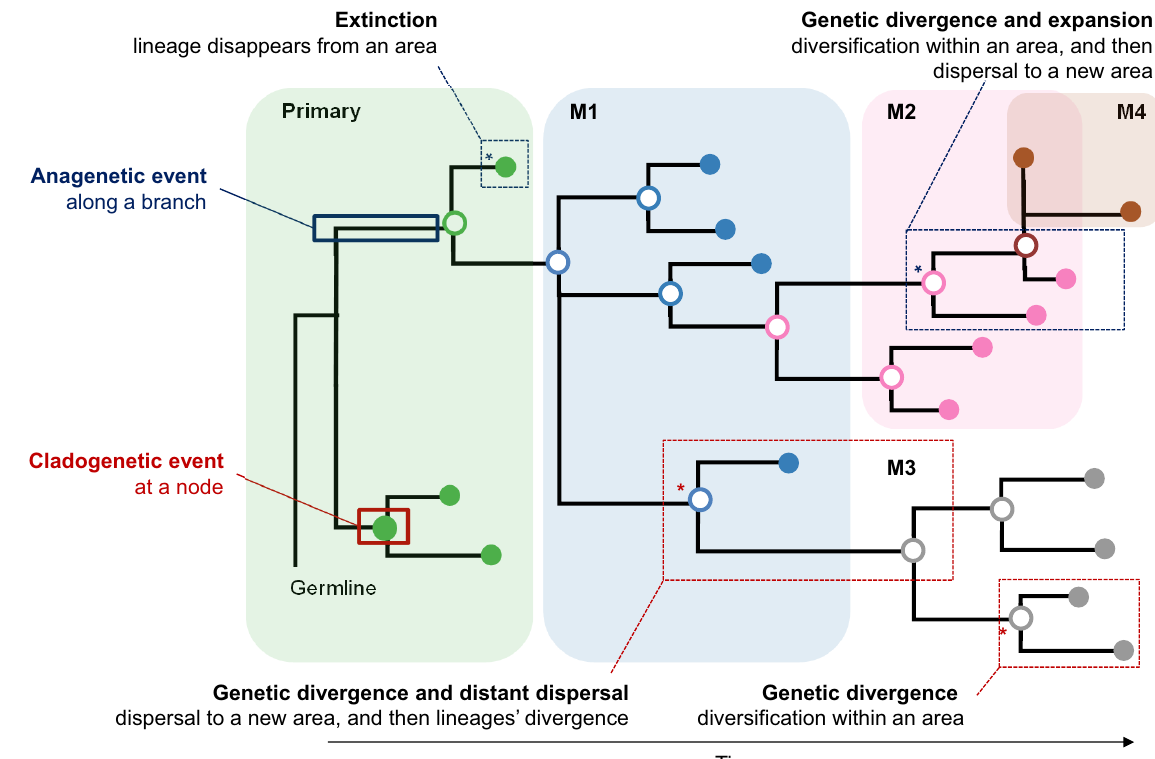
Figure. 1. A phylogeny traces the origin and trajectory of movements (anagenetic events in dark blue) and pinpoints diversification and speciation events (cladogenetic events in red). Biogeographic processes (dashed boxes) are exemplified into the presented clone phylogeny of one primary and four metastases: (i) genetic divergence: diversification within an area, (ii) extinction: lineage disappears from an area, (iii) genetic divergence and expansion: diversification within an area, and then dispersal to a new area, and (iv) genetic divergence and distant dispersal: dispersal to a new area, and then lineages’ divergence. Tumor clones are colored based on the source of tumor site: primary (green), and metastases M1 (blue), M2 (pink), M3 (gray), and M4